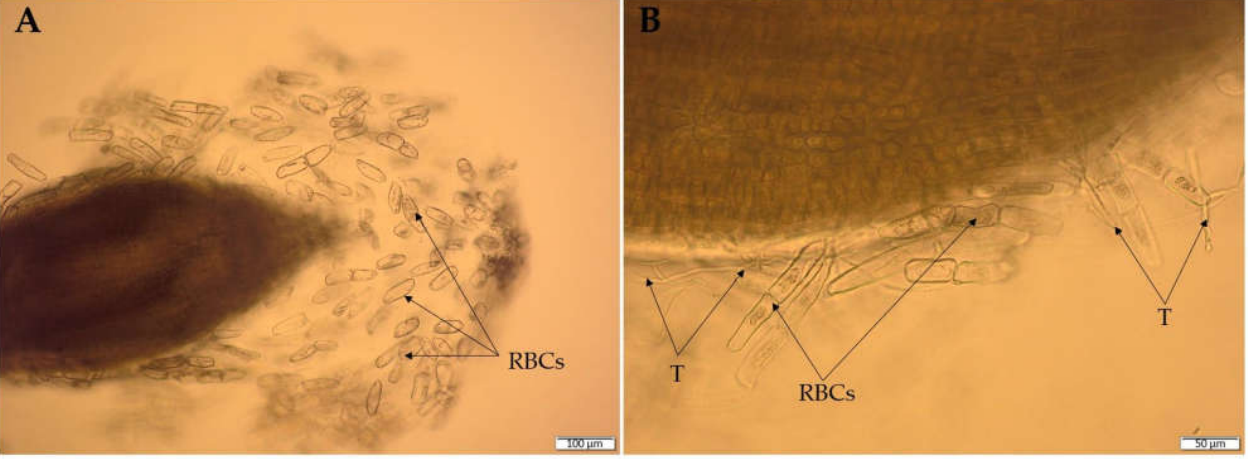
Figure 7. Wheat root border cells (RBCs) ( A ) and RBC colonization ( B ) by Trichoderma DEMTkZ3A0 hyphae (T) observed in microcultures on glass slides using an Olympus BX53 Upright Microscope equipped with a Olympus XC30 camera.